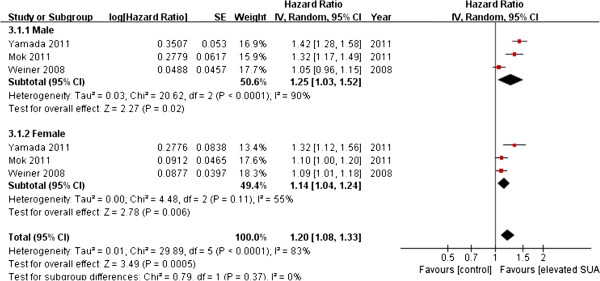
Forest plot of association between SUA and new-onset CKD in different genders.